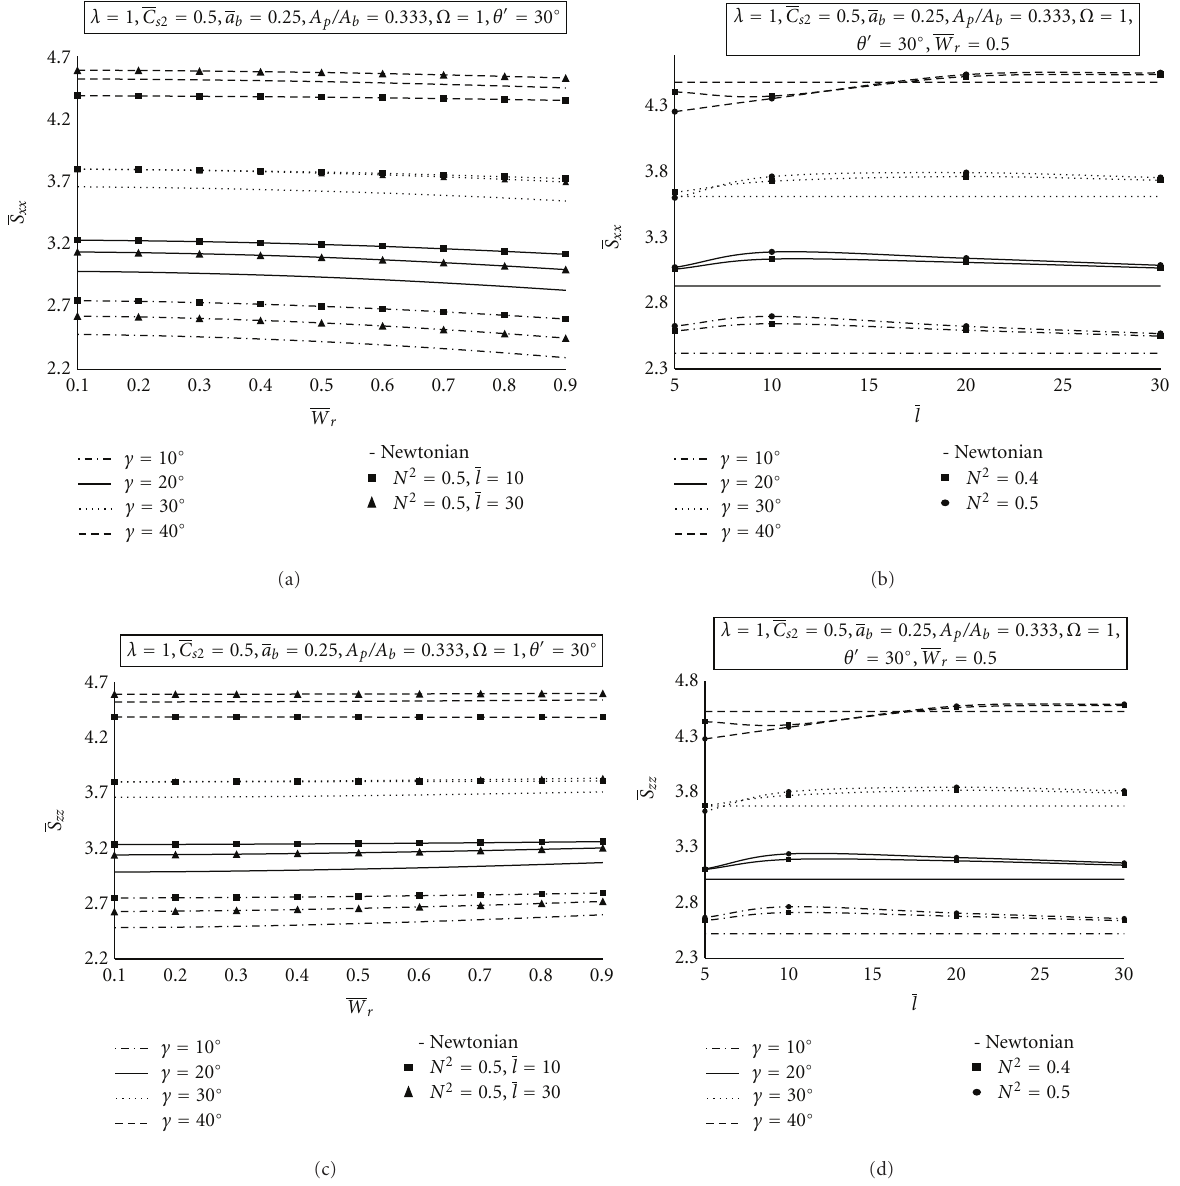
Figure 9: (a) Variation of S xx versus radial load W r . (b) Variation of S xx versus characteristic length l . (c) Variation of S zz versus radial load W S l r . (d) Variation of zz characteristic length